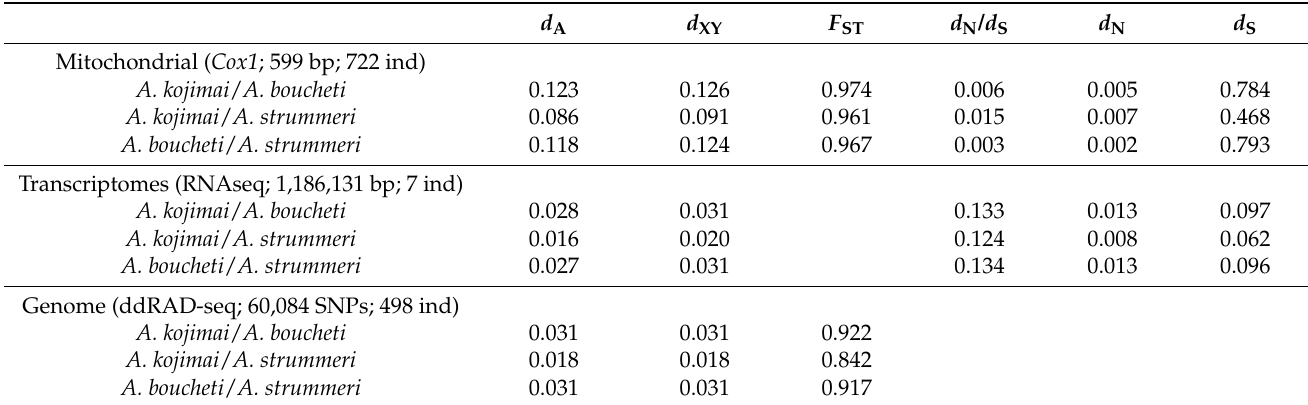
Table 2. Inter-specific genetic divergence and differentiation for the three genetic datasets: Cox1 mitochondrial gene (599 bp), ddRAD-seq SNPs (60,084 SNPs), and nuclear encoding RNAseq